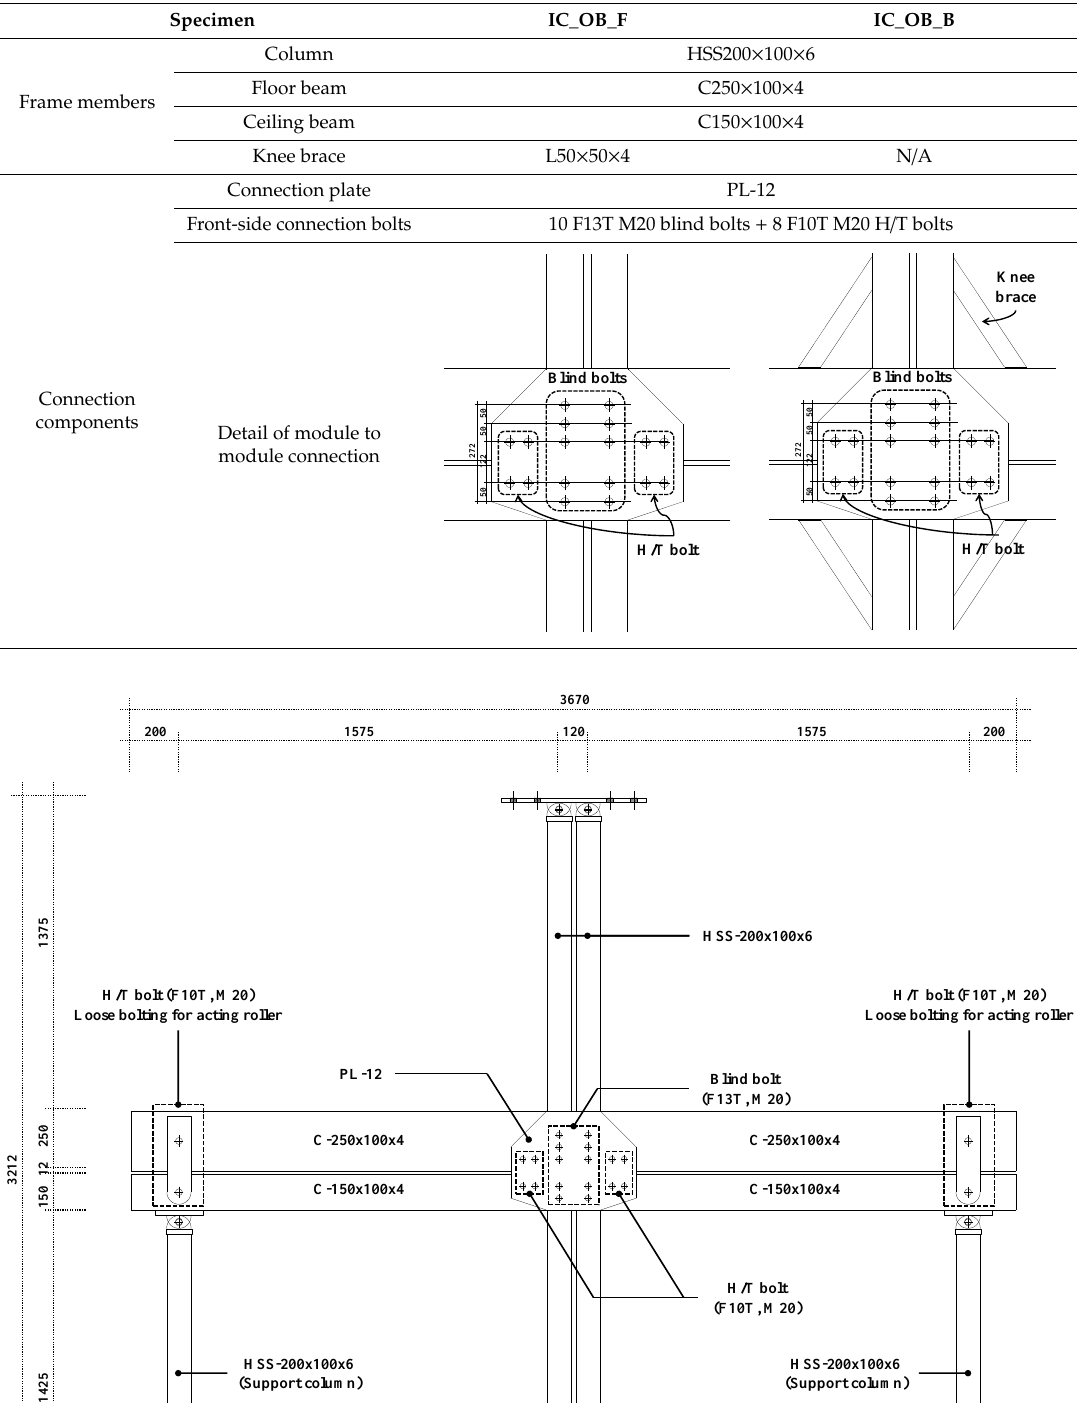
Table 1. Main features of two test specimens. (unit: mm).